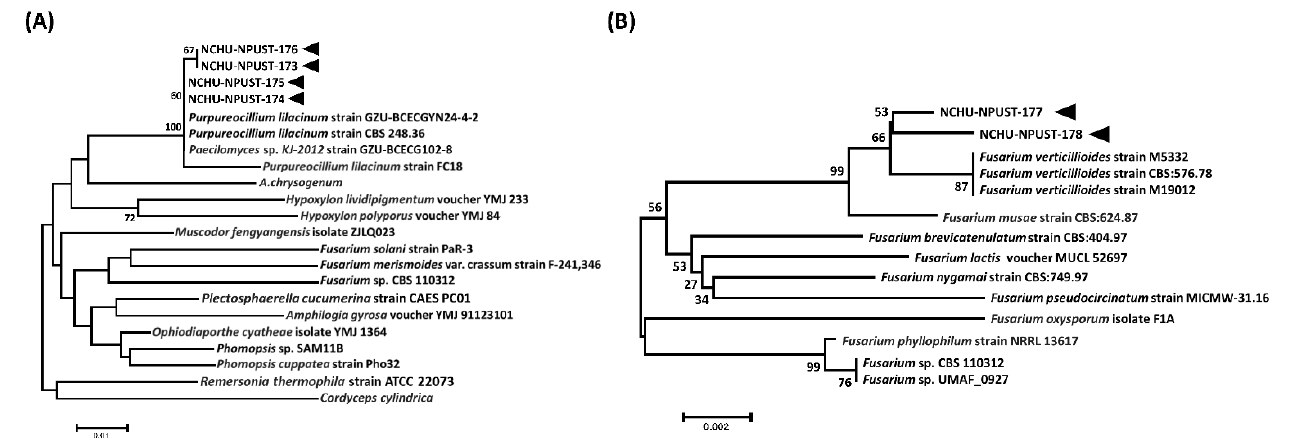
Figure 1. The phylograms of ( A ) Purpureocillium spp. (PL-NCHU-NPUST-173 to -176) and ( B ) Fusarium spp. (FV-NCHU-NPUST-177 and -178) based on the sequences of the part of beta-tubulin gene using the neighbor-joining (NJ) method. Bootstrap support values ≥ 50% are presented above the nodes. The black arrows indicate the fungal isolates used in this study.